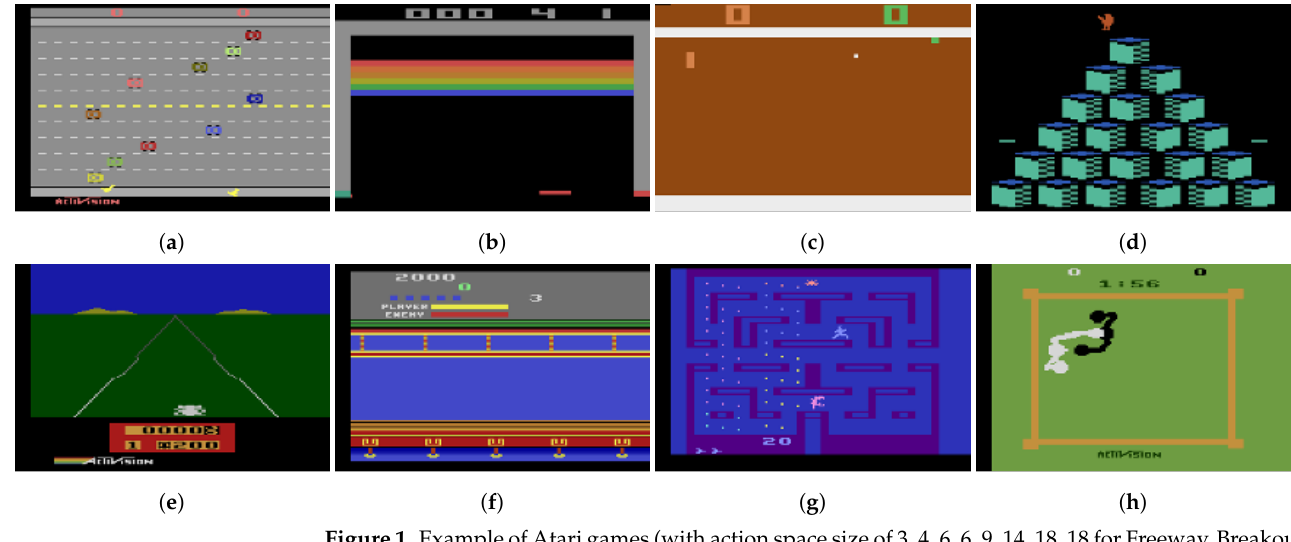
Figure 1. Example of Atari games (with action space size of 3, 4, 6, 6, 9, 14, 18, 18 for Freeway, Breakout, Pong, Qbert, Enduro, KungFuMaster, Alien, Boxing, respectively) used for the experimental study. ( a ) Freeway; ( b ) Breakout; ( c ) Pong; ( d ) Qbert; ( e ) Enduro; ( f ) KungFuMaster; ( g ) Alien; ( h )